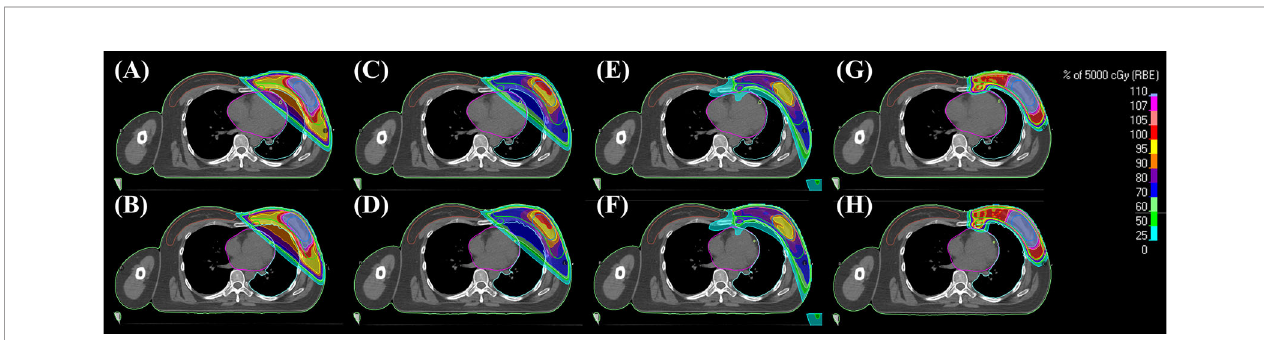
FIGURE 1 | Representative 2D dose distributions in a patient. (A) 3DCRT-FB-CF, (B) 3DCRT-CPAP-CF, (C) 3DCRT-FB-HF, (D) 3DCRT-CPAP-HF, (E) VMAT-FB-HF, (F) VMAT-CPAP-HF, (G) PBT-FB-CF, and (H) PBT-CPAP-CF on the same level cut of CT images. 3DCRT, three-dimensional conformal radiotherapy; VMAT, volumetric modulated arc therapy; PBT, proton beam therapy; CPAP, continuous positive airway pressure; CF, conventional fractionation; HF,